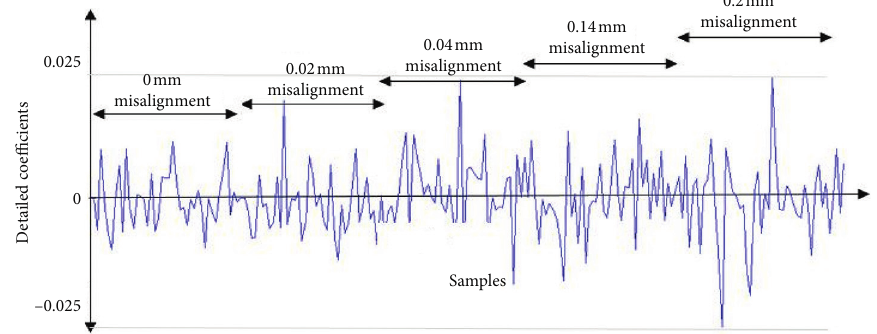
Figure 8: Detailed coefficients of vibration signals at the second level of